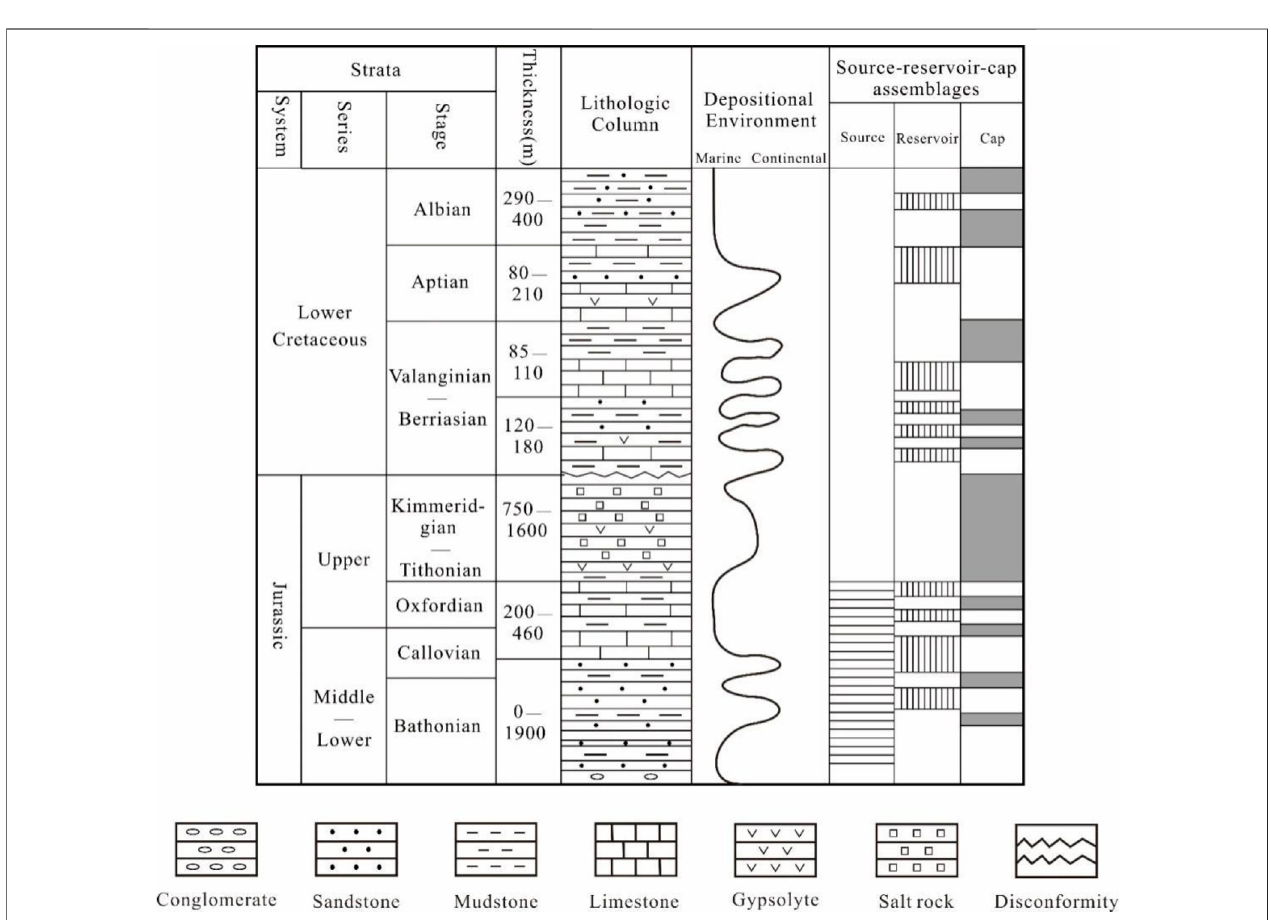
FIGURE 2 | The stratigraphic column of the Right Bank of the Amu Darya reservoirs.